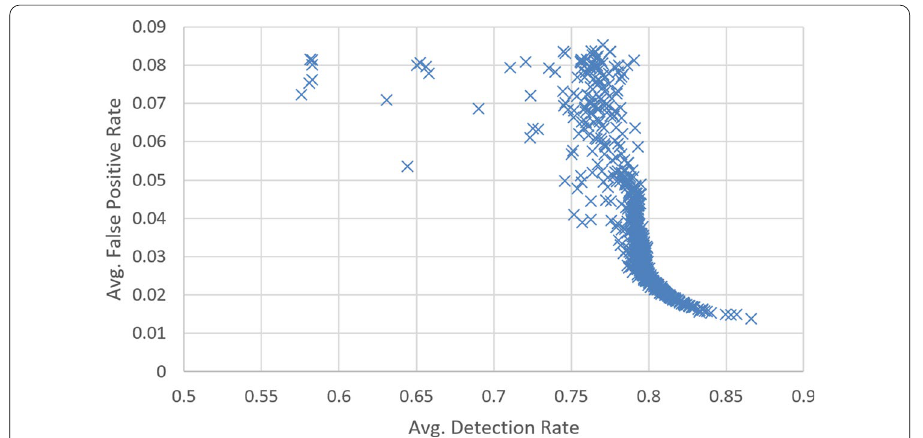
Fig. 8 Test performance of the proposed approach for DATASUBSET2